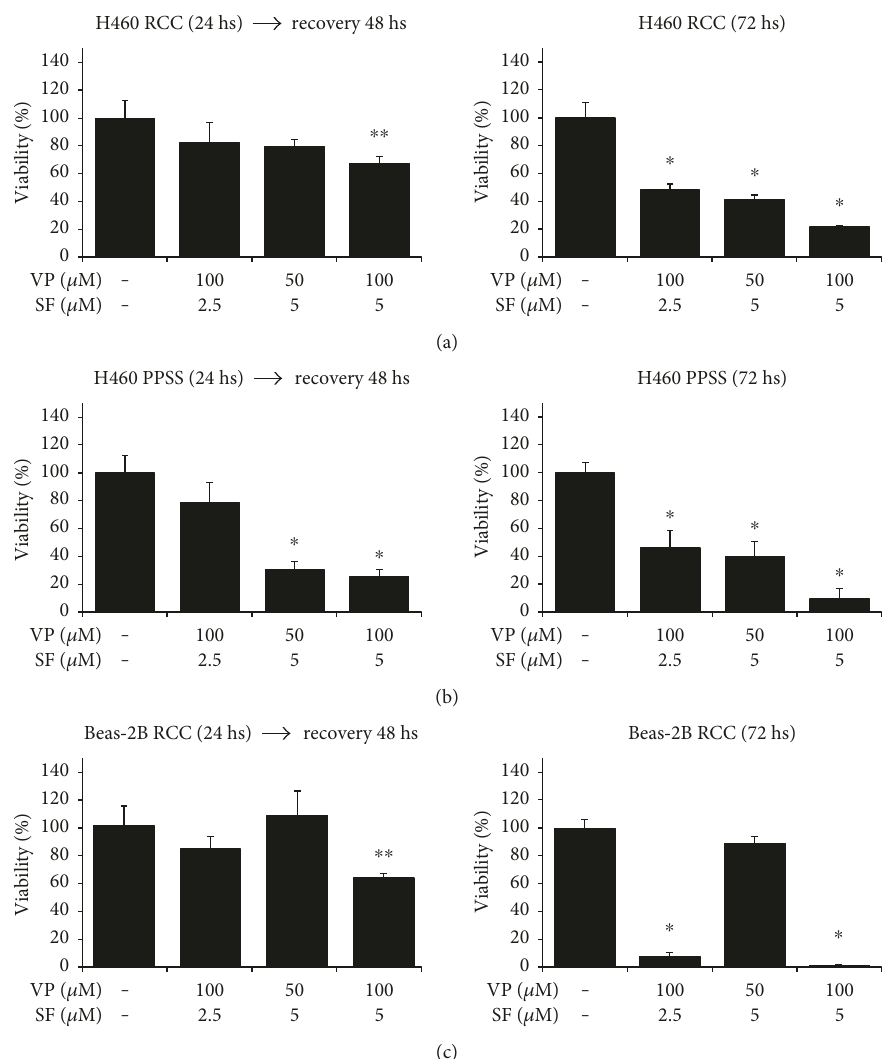
Figure 3: Short-term exposure to VP+SF irreversibly and selectively decreases the viability of cancer cells (H460) growing under RCCS as well as under PPSS. (a) H460 cells growing under RCCs were incubated with the indicated concentration of drugs for 24h and then allowed to recover in drug-free media for 48 h (left panel). In parallel, cells were treated with the same drugs for 72h (right panel). Cell viability was measured by the MTT assay. (b) H460 cells growing under PPSS (8 – 10 days) were incubated with the indicated concentration of drugs for 24h and then allowed to recover in drug-free media for 48h (left panel). In parallel, cells were treated with the same drugs for 72h (right panel). Cell viability was measured by the MTT assay. (c) Beas-2B cells growing under RCCs were incubated with the indicated concentration of drugs for 24 h and then allowed to recover in drug-free media for 48h (left panel). In parallel, cells were treated with the same drugs for 72 h (right panel). Results ( X ± SD) are representative of two independent experiments performed in sextuplicate. A simpli fi ed schema for the recovery experiments (left panels in a, b, and c) and continuous treatment with drugs for 72 h (right panels in a, b, and c) is shown in Figure S 2 ). ∗ and ∗∗ indicate P < 0 01 and P < 0 05 , respectively